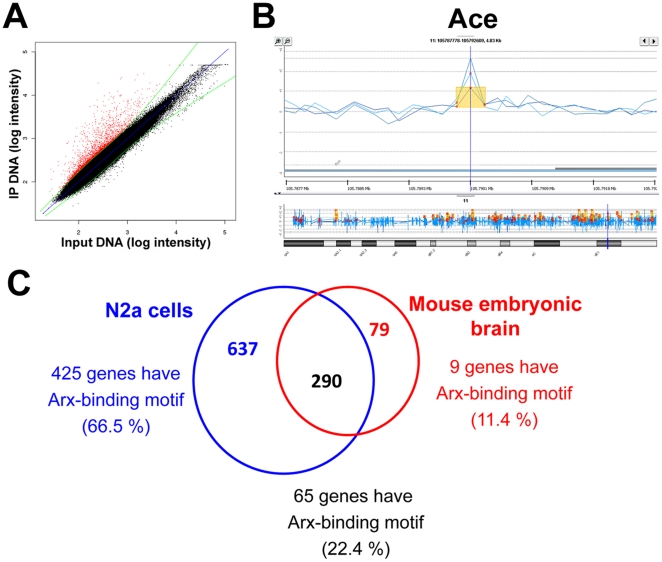
ChIP-chip results obtained from mouse embryonic brain.A) Graph representing log2 probe intensities of Arx-immunoprecipitated DNA (IP) and input DNA obtained in a representative ChIP experiment. The red dots indicate the probes enriched in Arx-immunoprecipitates compared to total input DNA. B) Example of the enrichment profiles of Arx-bound promoter regions visualized by DNA analytics. The 3 lines represent data obtained from 3 independent ChIP-chip experiments and show the reproducibility between the 3 replicates. Contrarily to N2a cells, in which several continuous probes were often found enriched, only one or two probes were found enriched per gene. C) Venn diagram illustrating the overlap (black) between Arx-immunoprecipitated genes in transfected N2a cells (blue) and mouse embryonic brain (red), and the number of genes with at least 75% match to Arx-binding motif.